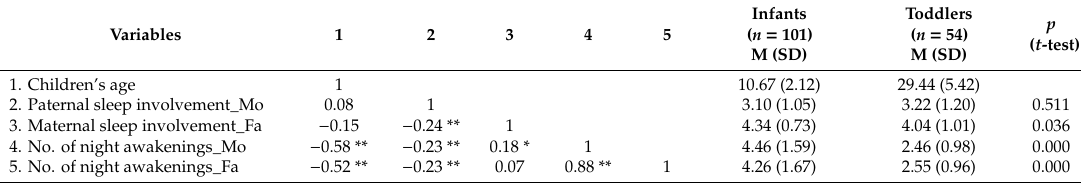
Table 1. Correlations, means, standard deviations, and t -test of the study variables. Variables 1 2 3